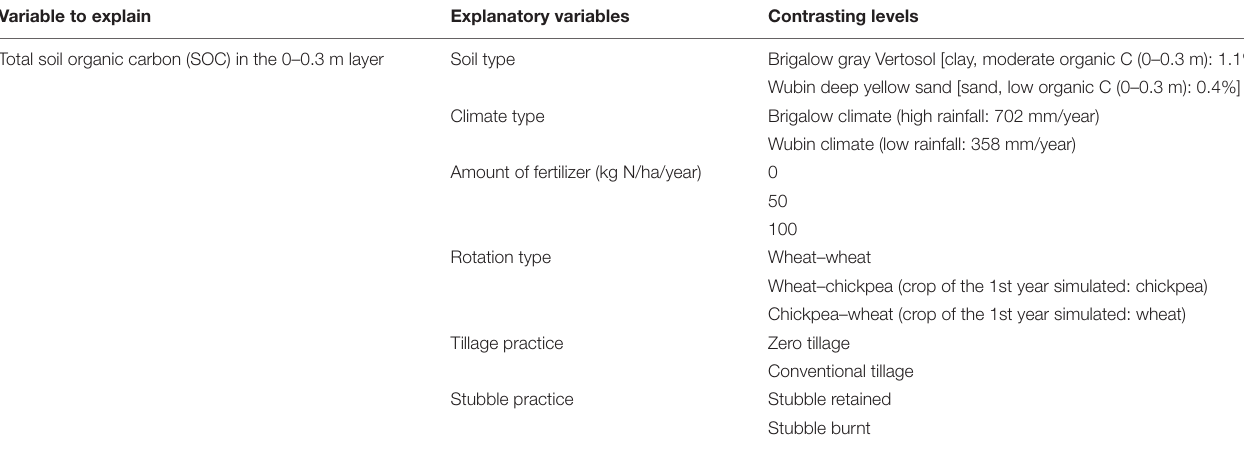
TABLE 1 | Explanatory variables of the Agricultural Production Systems sIMulator model and their levels. Variable to explain Explanatory variables Contrasting levels Total soil organic carbon (SOC) in the 0–0.3 m